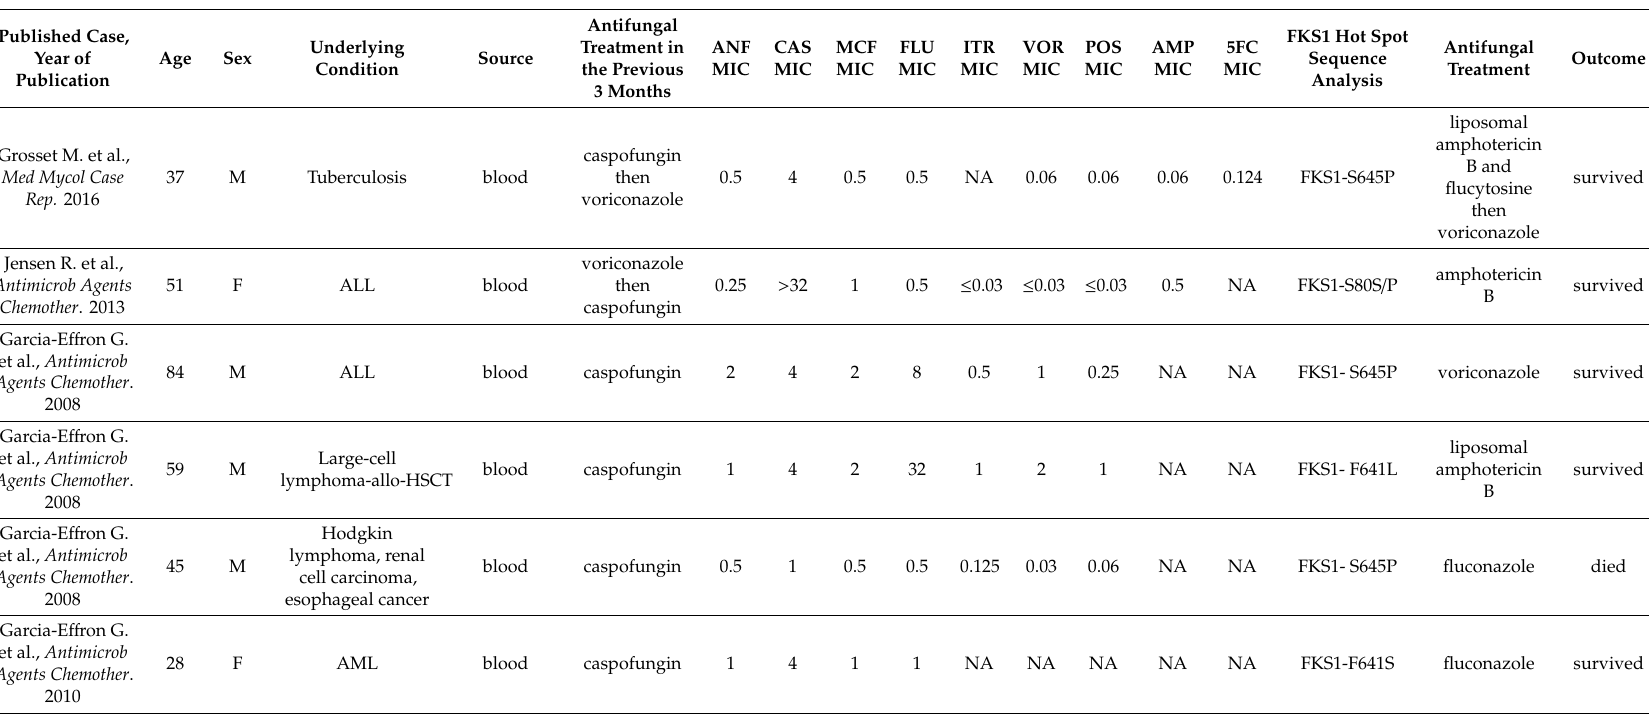
Table 2. Characteristics of the cases of echinocandin-resistant Candida tropicalis